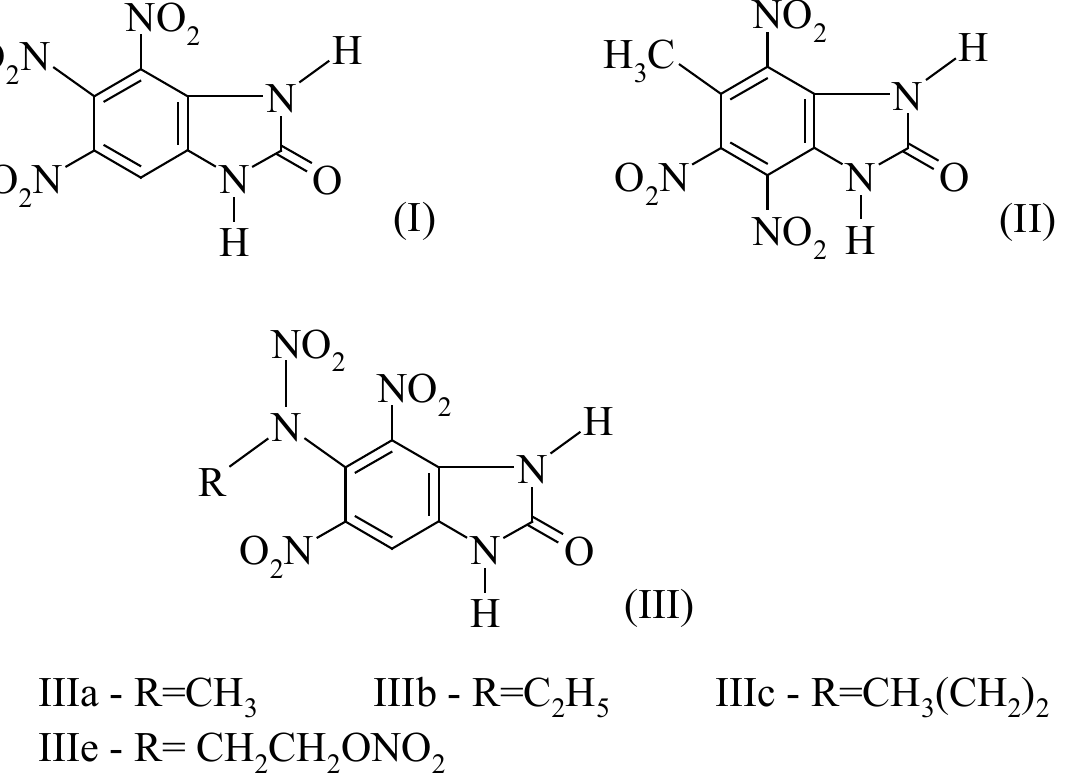
Figure 1. Structures of prepared 1,3-dihydro- 2H -benzimidazol-2-one nitro and nitramino derivatives.